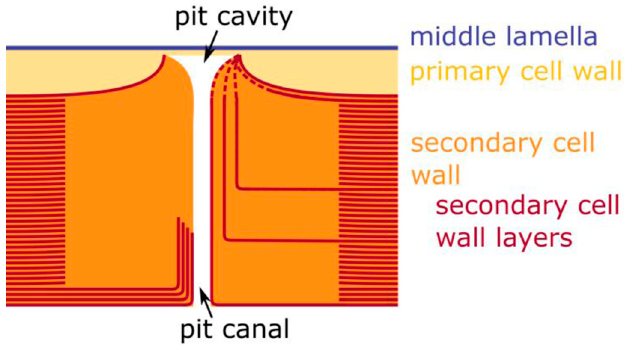
Figure 9. Diagram of a bordered pit. Left side of the pit cavity: Observed structural features. Right side of the pit cavity: Hypothesized structuring in the vicinity of the pit cavity (for reasons of clarity not all individual cell wall layers-red lines- are traced to the pit cavity).